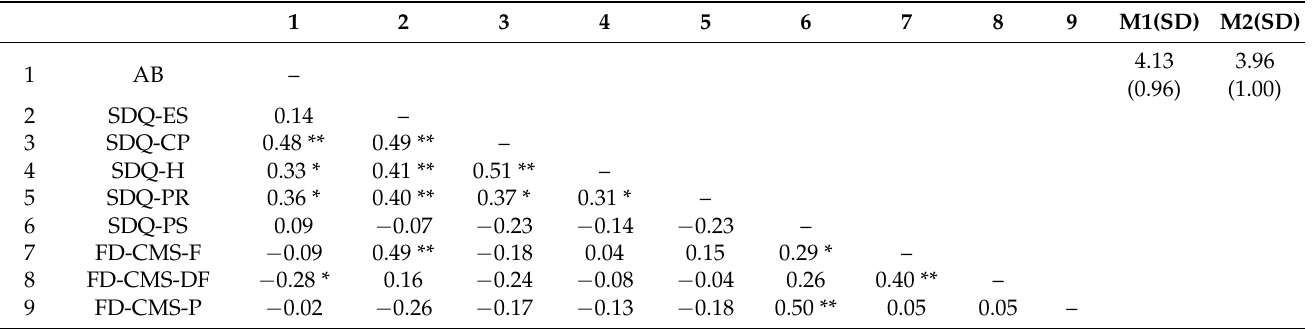
Table 1. Correlations between changes in attentional bias and changes in mental health